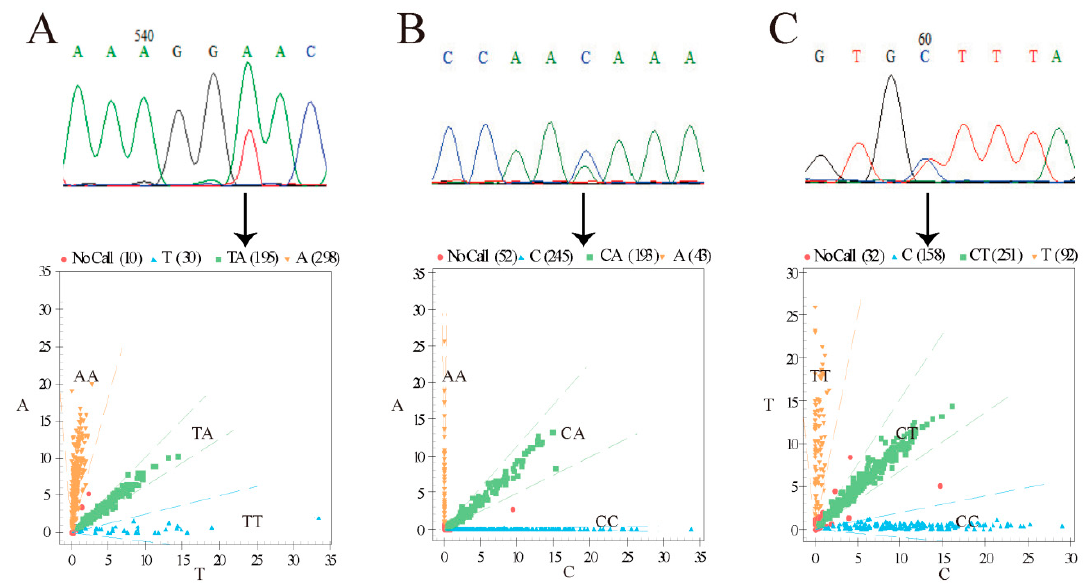
Figure 1. BMP2 gene pool sequencing and genotyping results. (A) Site of g.48401619 T > A. (B) Site of g.48401272 C > A. (C) Site of g.48401136 C > T. Yellow region, blue region, and green region represent di ff erent genotypes. Numbers in brackets indicate number of individuals of the three genotypes. Chromatograms from DNA pool sequencing are shown in the top row, while the mass spectrometry